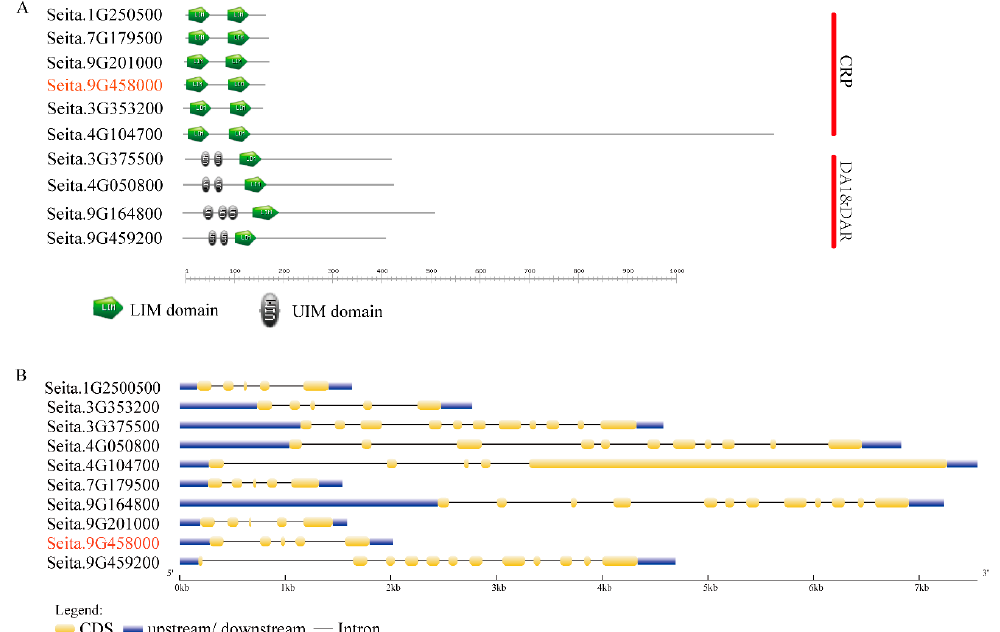
Figure 2. Functional domain and gene structure analysis of foxtail millet LIM genes. ( A ) Function domains in foxtail millet LIM proteins. The green pentagon represents the LIM domain, and the gray-black ellipse represents the UIM domain. Members of the PLIM and WLIM subgroups of foxtail millet each contain two LIM domains. Members of the DA1&DAR subgroup contain only one LIM domain and two to three UIM domains. ( B ) Intron–exon structures of SiLIM genes. The intron-exon structures were obtained by comparing the coding and genomic sequences using the GSDS website. Yellow and blue boxes represent coding regions and untranslated upstream/downstream regions, respectively. Lines indicate introns. Red represents the SiWLIM2b gene.